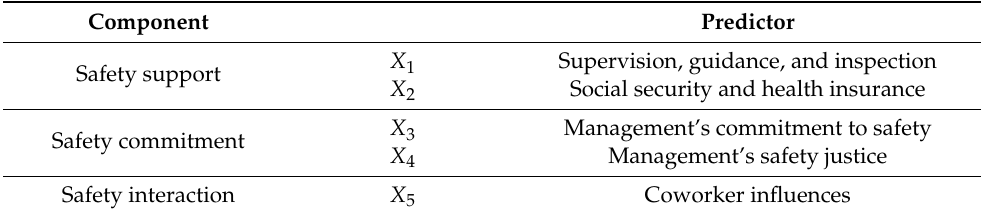
Table 3. Construction site safety climate predictors retained in the prediction